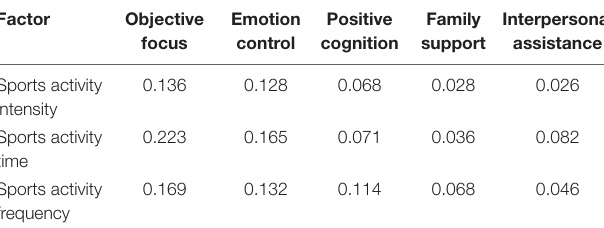
TABLE 4 | Correlation matrix between sports activity participation and mental toughness and